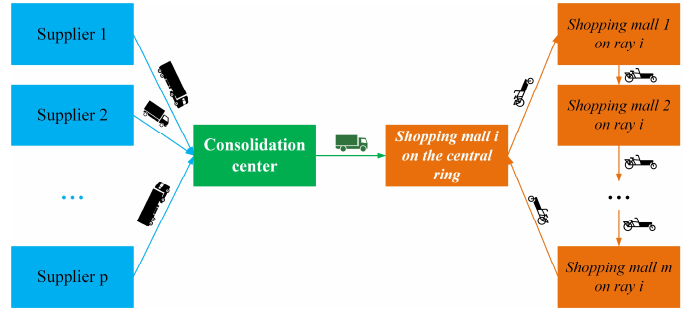
Figure 4. Examined new city logistics concept with cargo bikes.